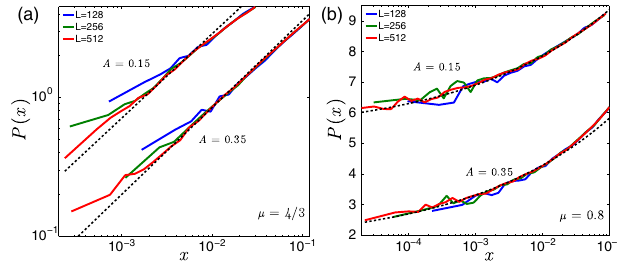
FIG. 3. P ð x Þ for μ ¼ 4 = 3 (a) and μ ¼ 0 . 8 (b) for N ¼ L 2 as shown in the legend. (a) The dashed line is the theoretical value θ ¼ 0 . 667 ; the measured values are θ ¼ 0 . 61 (cid:3) 0 . 04 ( A ¼ 0 . 15 ) and θ ¼ 0 . 62 (cid:3) 0 . 03 ( A ¼ 0 . 35 ). (b) The dashed line is the fits of Eq. (15), which are P ð x Þ ¼ 5 . 273 þ 6 . 506 x 0 . 2 ( A ¼ 0 . 15 )